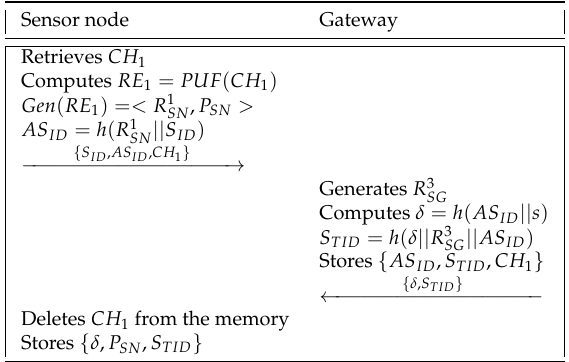
Figure 5. Sensor node registration phase of the proposed